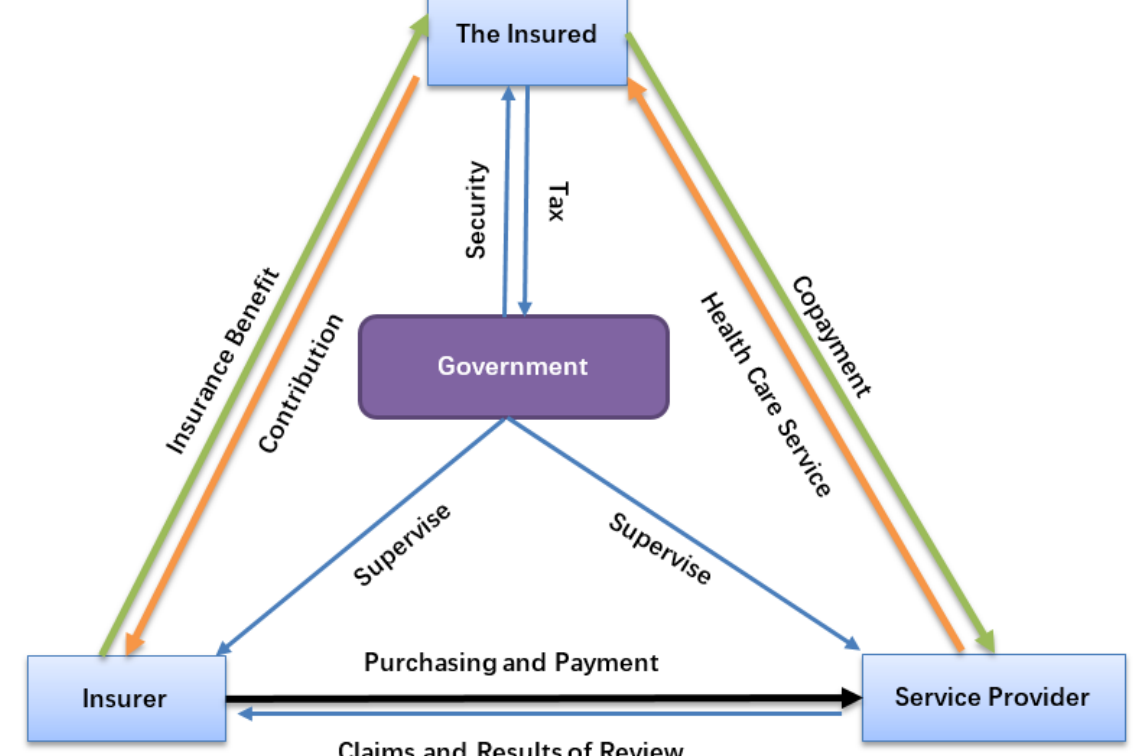
Figure 3. Business model chart of China’s medical insurance information systems (MIISs), modified from the the National Health Information Database of the National Health Insurance Service in South Korea (Cheol Seong et al,